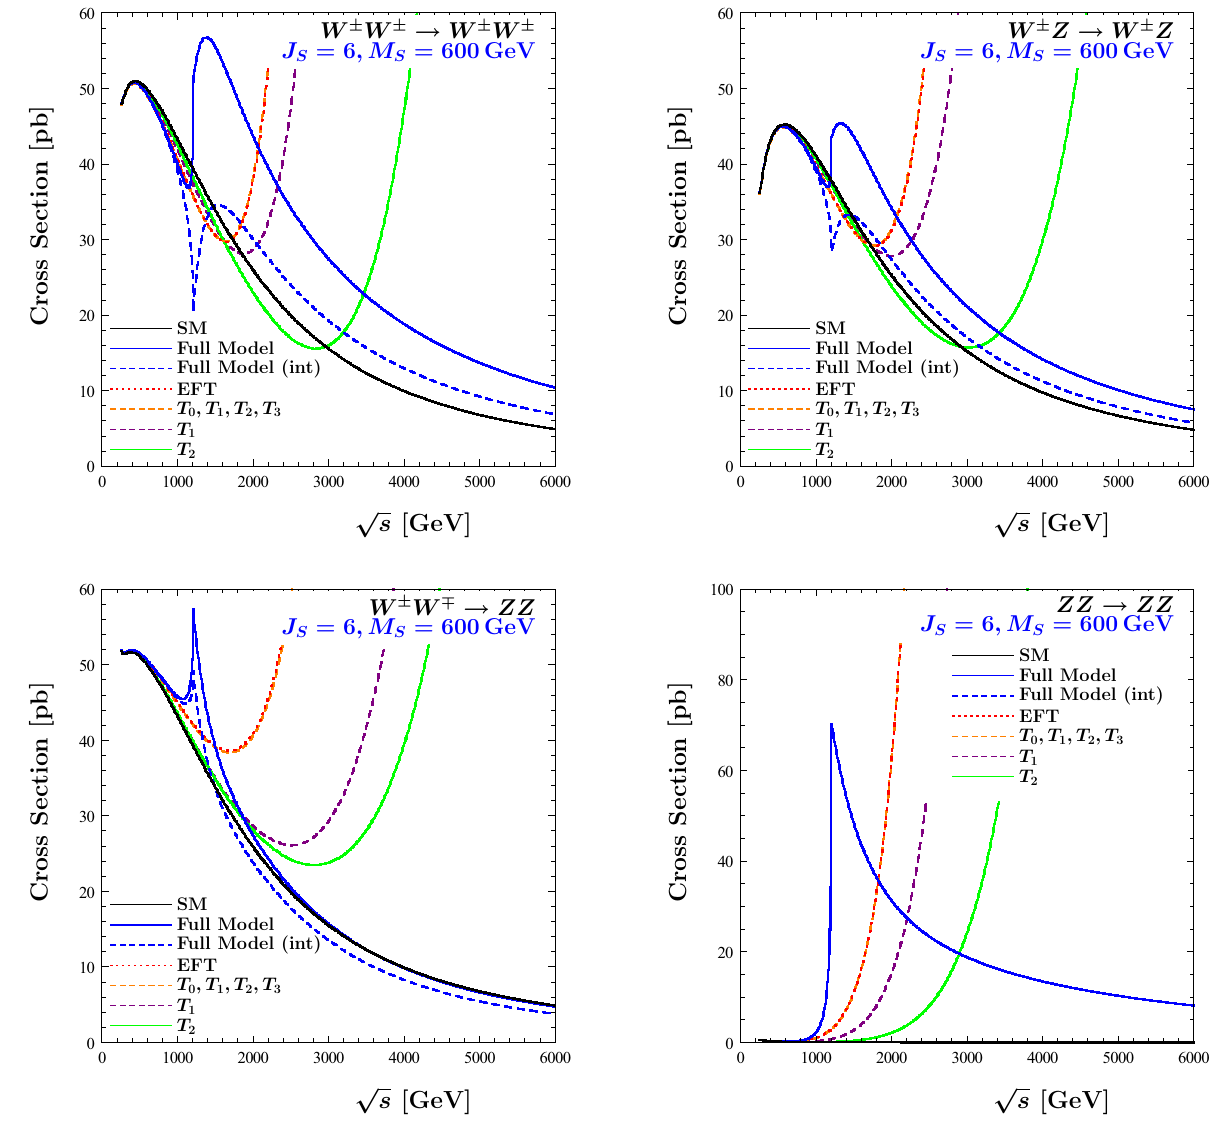
Fig. 6 Same as Fig.5, but for a single scalar multiplet with J S = 6 , M S =